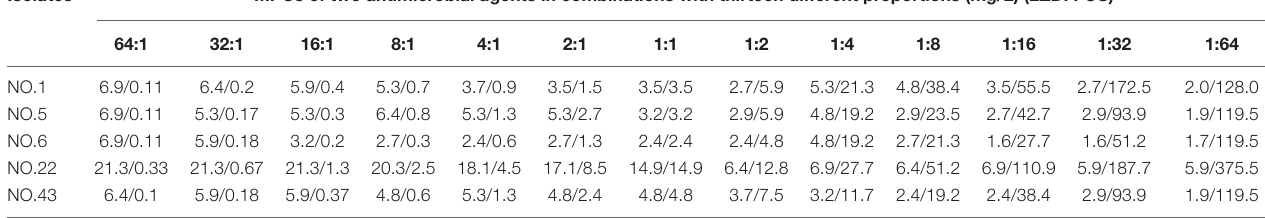
TABLE 2 | MPCs of linezolid and fosfomycin in combinations with thirteen different proportions. Isolates MPCs of two antimicrobial agents in combinations with thirteen different proportions (mg/L) (LZD: